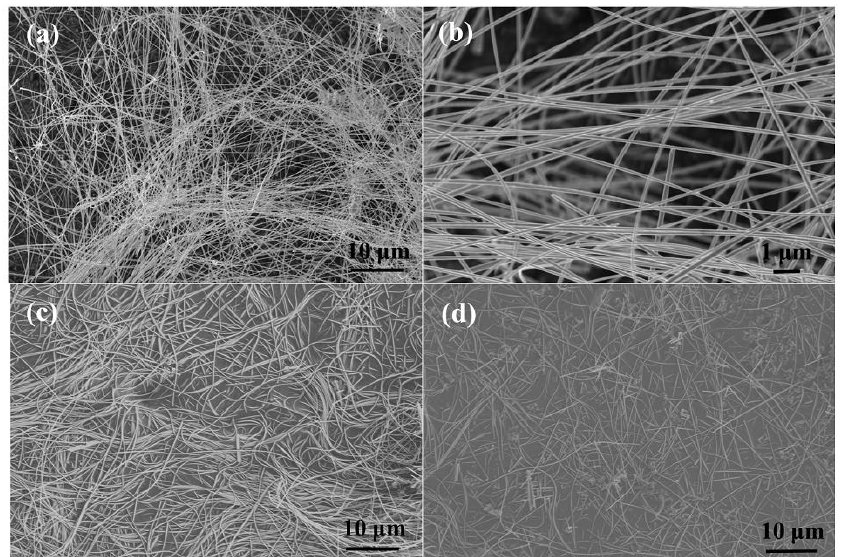
Figure 3. SEM images of hydrothermally-prepared PPy/Cu 2 O nanowires at different temperatures: ( a , b ) 120 °C; ( c ) 140 °C; and ( d ) 160 °C.